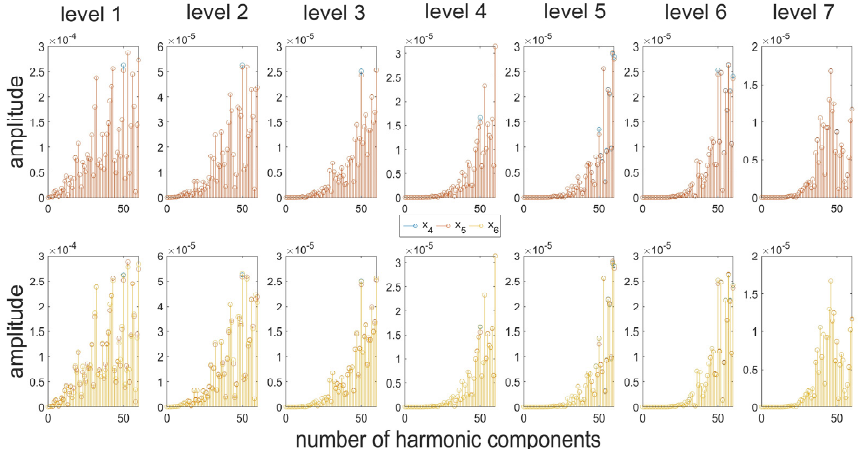
Figure 10. A Spectrum of surface pro fi les for seven levels of analysis - the db1 wavelet.